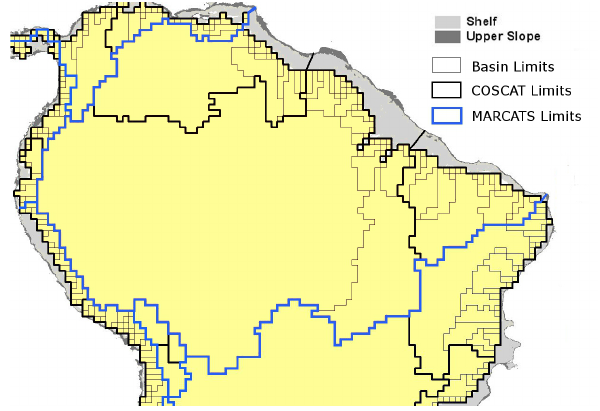
Fig. 1. Map of equatorial South America displaying the 3 lay- ers of the segmentation and their boundaries (1 – watersheds, 2 – COSCATs, 3 –